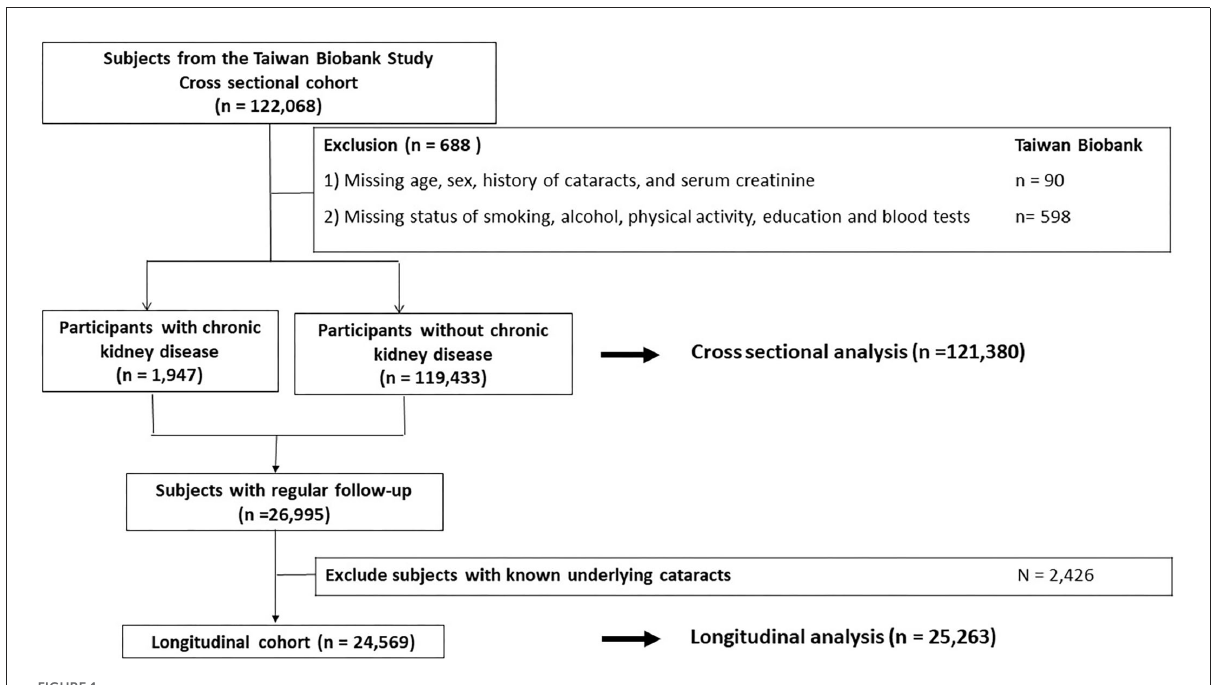
FIGURE1 Study participants were classified by the presence of chronic kindey disease.